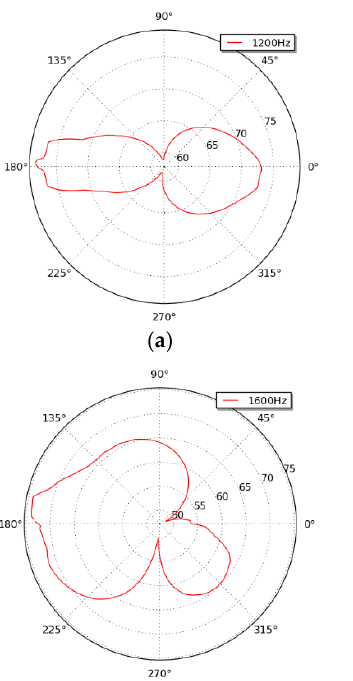
17 of 24 Figure 14. Contour of sound pressure of the sail hull: ( a ) f = 10 Hz; ( b ) f = 50 Hz; ( c ) f = 100 Hz; ( d ) f = 150 Hz; ( e ) f = 200 Hz; ( f ) f = 600 Hz; ( g ) f = 800 Hz; ( h ) f = 1200 Hz; ( i ) f = 1800 Hz; and ( j ) f = 2000Hz. The contour of sound pressure at plane A is shown in Figure 14. The distributions of the sound field at different frequencies are approximately symmetrical with the chord of the sail hull. Because the primary source of the flow ‐ induced noise in the low ‐ frequency range is the horseshoe vortex, which has a large scale, and the distribution of the turbulent fluctuation pressure is roughly symmetrical to the chord of the sail hull. With the increase of the frequency, the distribution of the sound field of the sail hull becomes complicated. The boundary layer separation and the tail vortex shedding are ascribed to the sail hull excited to generate the flow ‐ induced noise in the high ‐ frequency range, and the structure of the vortices from the two flow phenomena is interlaced and not symmetrical to the chord of the sail hull. Therefore, the distribution of sound pressure is not entirely symmetrical to the chord of the sail hull. 5.5. Directivity of Sound Radiation Figure 15 shows the horizontal directivities of the sound field of the sail hull at f = 10 Hz, 50 Hz, 100 Hz. At these lower frequencies, the sound radiation of the sail hull has the same horizontal directivity, the sound field is not symmetrical to the chord, and the angle with the intensive radiated noise is in the range from 45° to 135°. Figure 15. Horizontal directivity of sound pressure of the sail hull in low ‐ frequency range. The pink line denotes the frequency of 10 Hz. The red line denotes the frequency of 50 Hz. The black line denotes the frequency of 100 Hz. The horizontal directivity of the sail hull in high ‐ frequency range is shown in Figure 16. The leading edge of the sail hull is mainly excited by the horseshoe vortex, which contributes very little